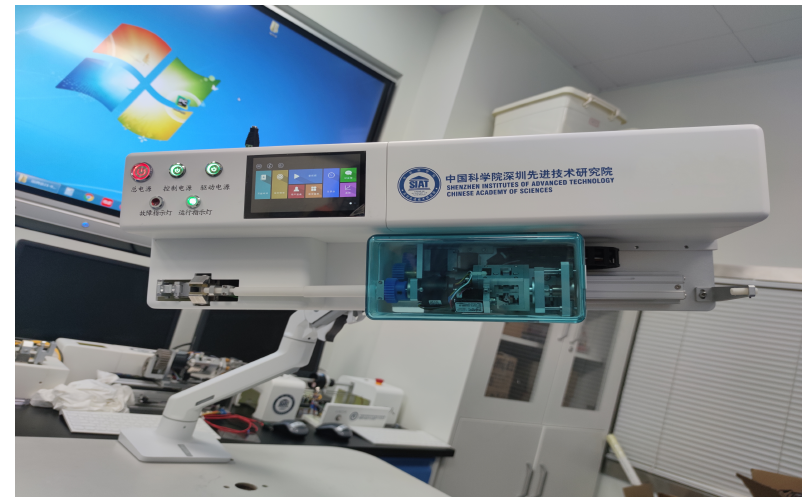
Figure 6. Slave manipulator of the VISR.